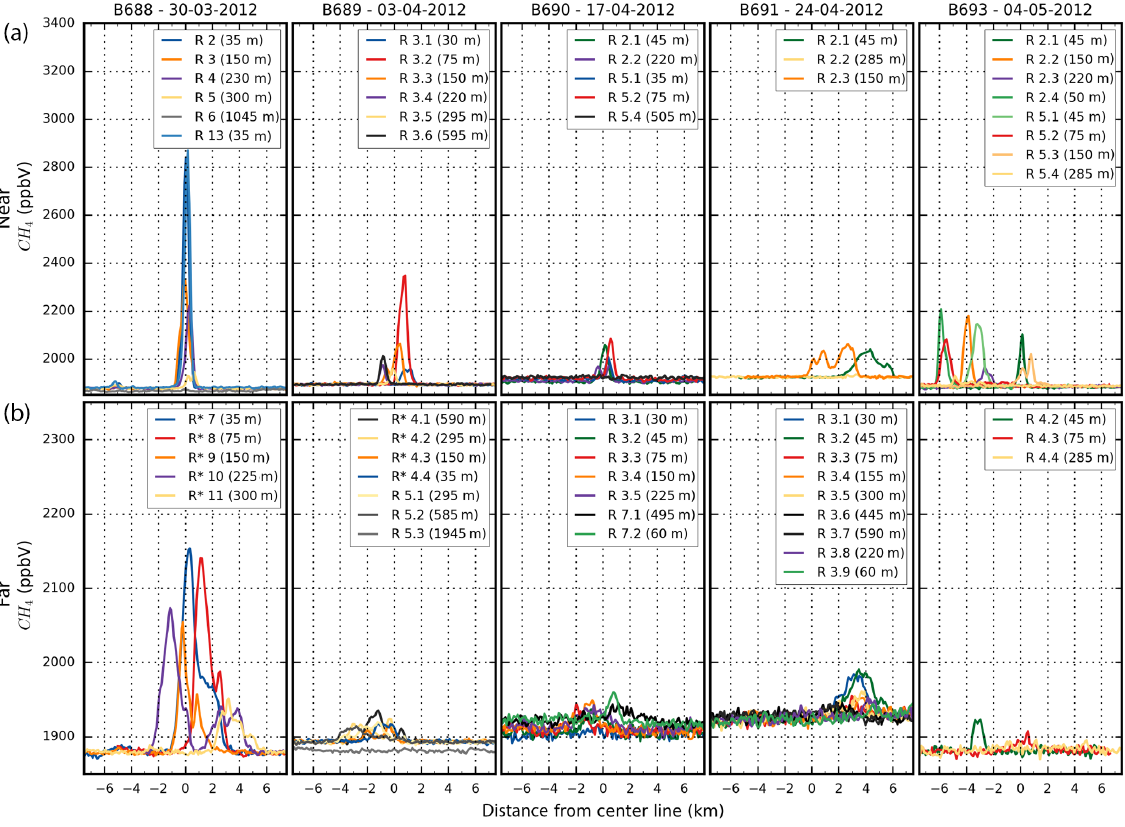
Figure 4. CH 4 measurements taken downwind of the Elgin rig during five flights. Panels (a) show data taken at 5NM and panels (b) data for 15 and 20NM. Different colours show data for different runs. Runs at 15NM downwind are denoted with an “ ∗